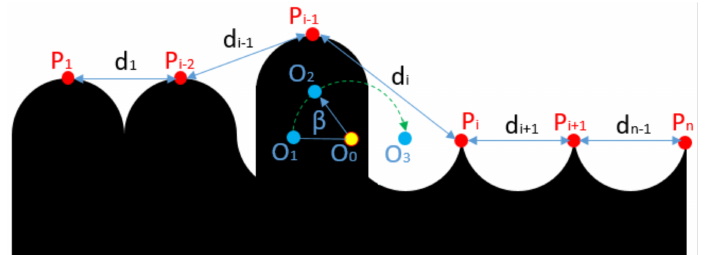
Figure 13. Projection diagram of the rope arrangement in the case of the rope skipping fault.